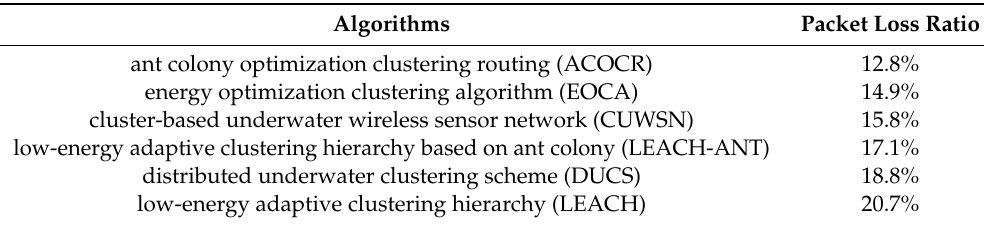
Table 2. The packet loss ratio for the six algorithms.